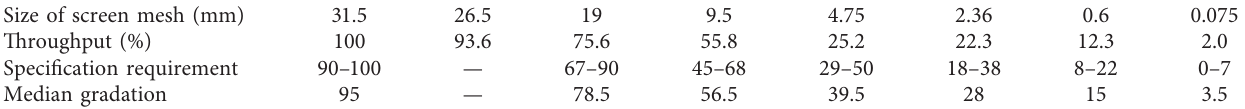
Table 1: The screening results of recycled aggregate.